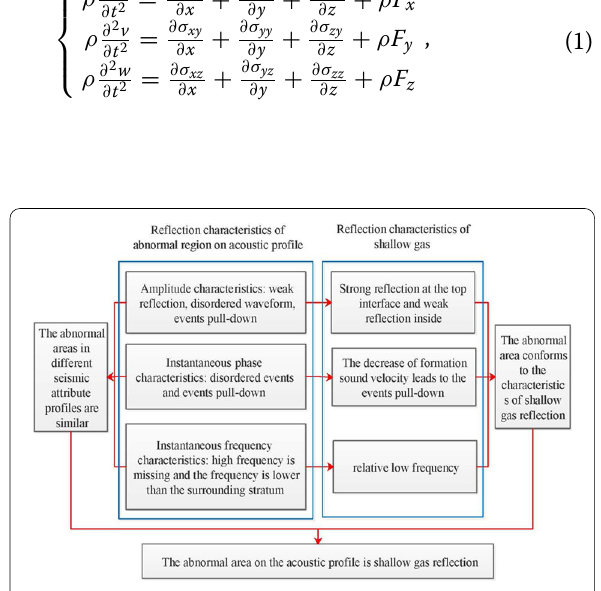
Fig. 1 Method for the identification of shallow